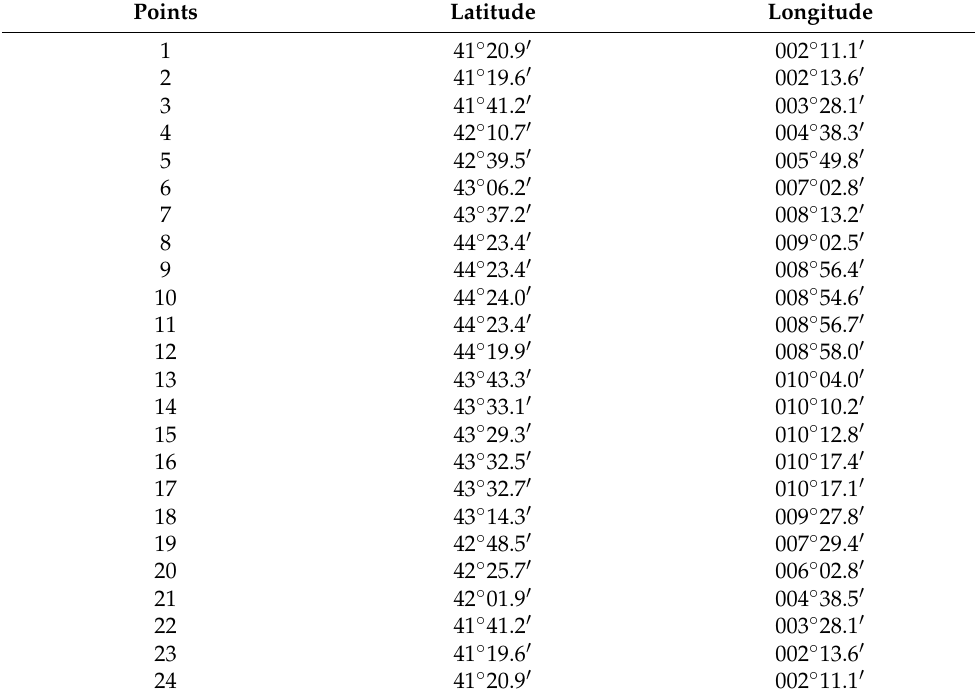
Table A1. Way points of sections of route selected (Barcelona–Genoa–Livorno–Barcelona).